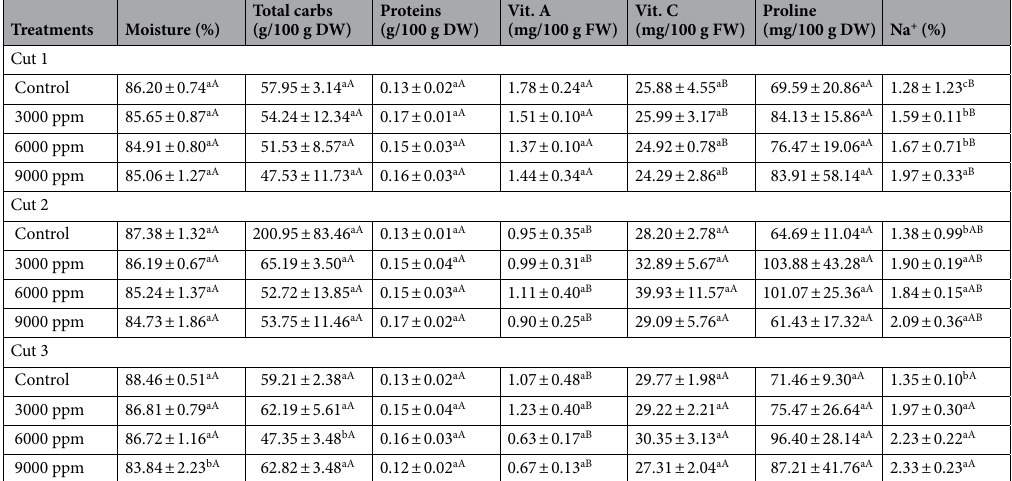
points, with 3000, 6000, and 9000 ppm having a percentage increase in the Na + concentration in cut 2 (19.5, 10.2, and 6.1%, respectively) and cut 3 (23.9, 33.5, and 18.3% respectively) relative to cut 1. As shown in Table 8, no significant differences in the leaf concentrations of macro-elements (nitrogen [N], phosphorus [P], potassium [K], magnesium [Mg], and calcium [Ca]) were noted among all treatments. The P content of leaves in cut 2, however, increased by 92.3 and 18.4% in 6000 ppm and 9000 ppm, respectively. Furthermore, the K content of leaves in cut 2 increased by 11.3, 16.3, 1.5, and 19.8% in control, 3000, 6000, and 9000 ppm, respectively. Data on the Mg content of leaves in cut 2 showed a percentage decrease of 21.7, 15.0, 30.9, and 15.3% in control, 3000, 6000, and 9000 ppm, respectively whereas in cut 3, a percentage decrease of 24.7, 25.4, 29.1, 18.3% was noted in the control, 3000, 6000, and 9000 ppm respectively. For Ca content in cut 2, the results